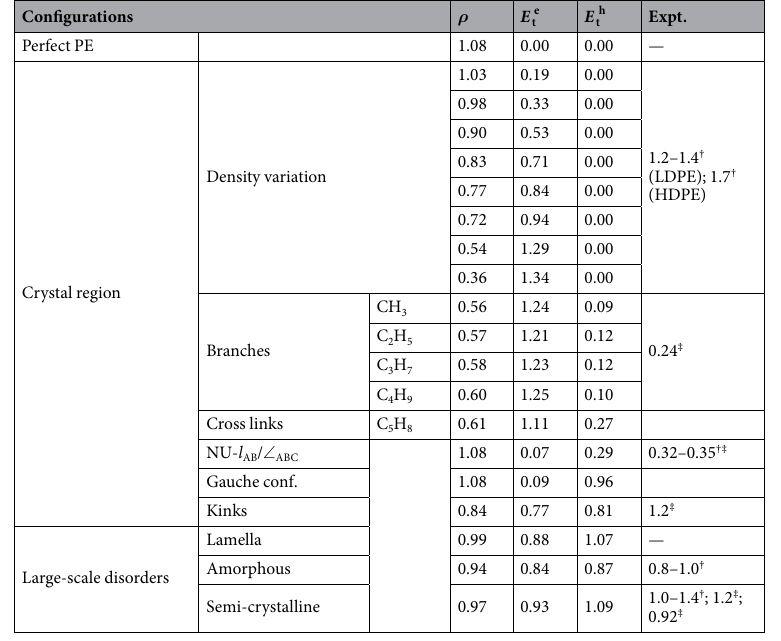
Table 2. Computed electron and hole trap depths ( E te and E th ), given in eV, of PE with physical disorders. Experimental values of E te and E th are given when available. The density ρ of PE (with disorders) is given in g/ cm 3 . † Ref. 28; ‡ Refs 49, 50 and 55; †‡ Ref.